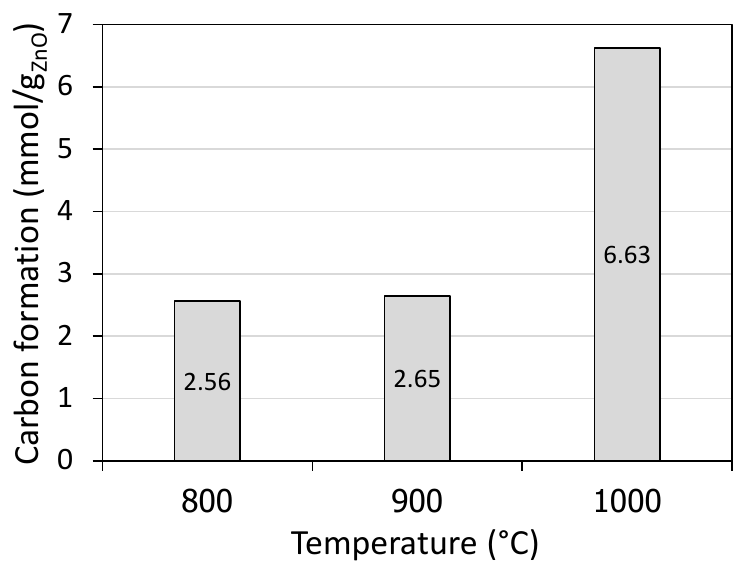
Figure 2. Solid carbon formation as a function of temperature at atmospheric pressure. Source: author.